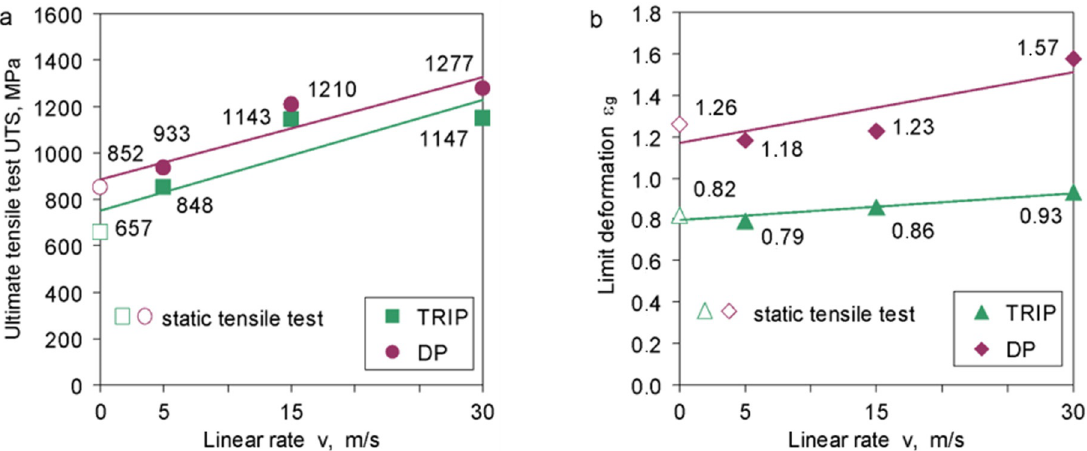
Figure 8. Tensile strength ( a ) and limit of deformation ( b ) as a function of the linear rate of the impact hammer for TRIP and